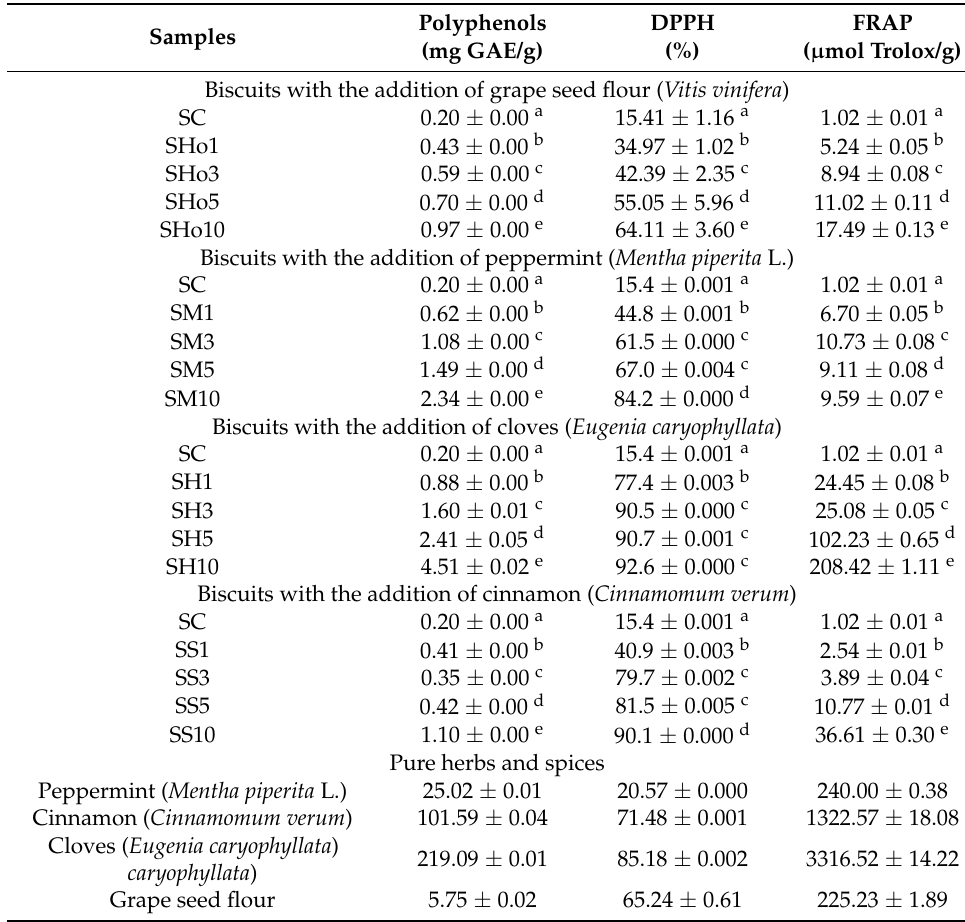
Table 1. Polyphenol content and antioxidant capacity measured by the DPPH and FRAP methods of experimentally produced